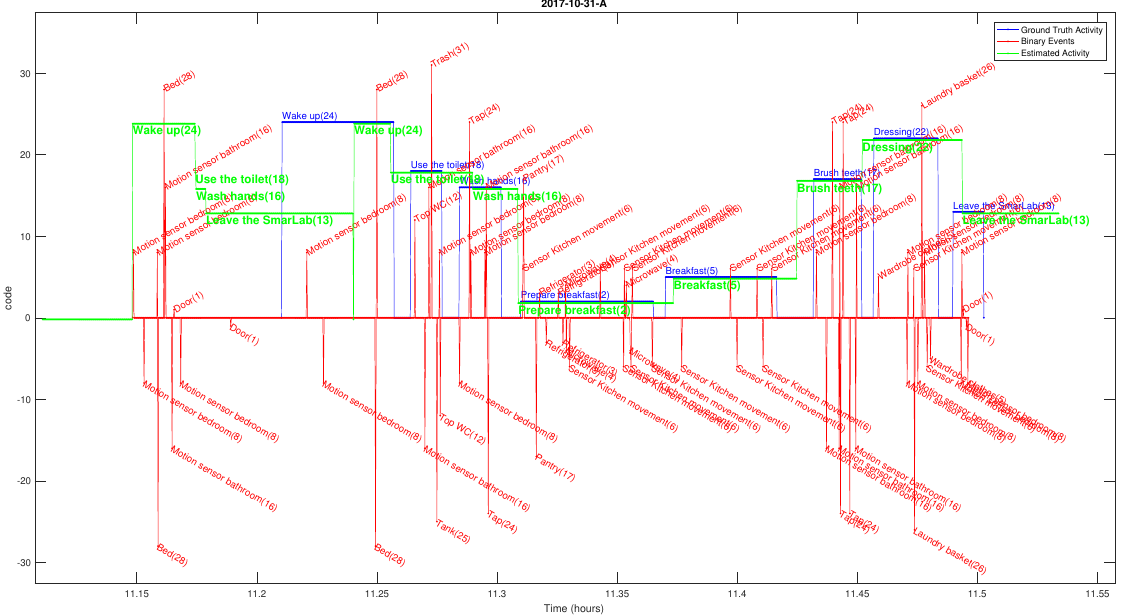
Figure 2. Timeline example for event registration and activity labeling. The red spikes are the readings from binary sensors, the continuous blue lines are ground-truth activities and in green their